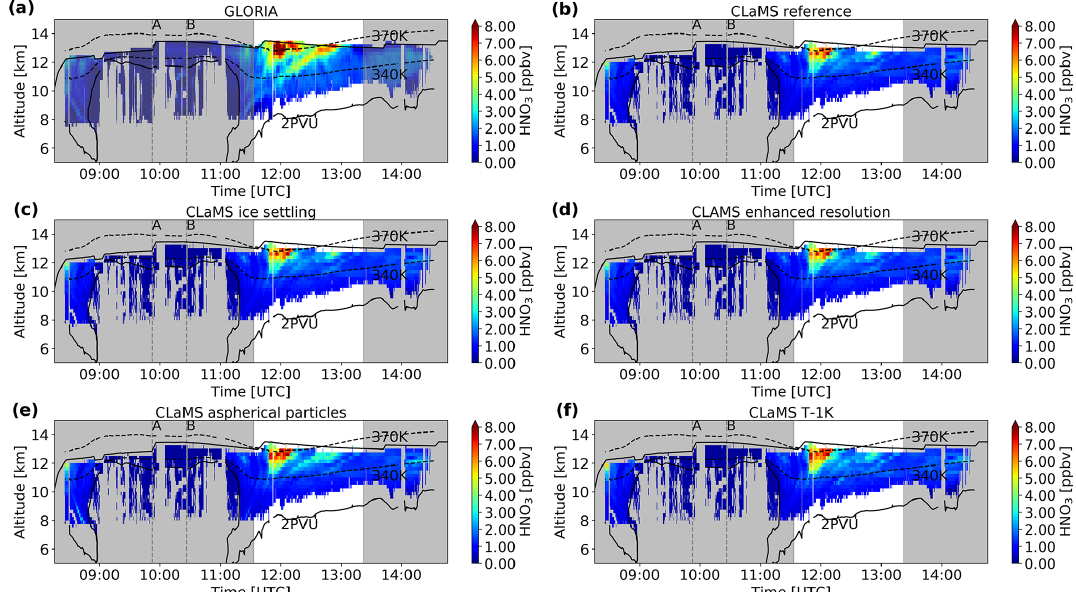
Figure B1. Cross sections of HNO 3 volume mixing ratio distribution for flight 6 on 12 January 2016 derived by GLORIA (a) and modelled by the CLaMS reference simulation (b) , and sensitivity simulations considering (c) ice formation on NAT particles, (d) temperature fluctuations, (e) growth rates of aspherical particles and (f) 1K global temperature offset. Flight altitude (bold black line), characteristic waypoints (A, B, C), 340 and 370K potential temperature levels (MERRA-2, dashed black lines), and 2PVU level (MERRA-2, black line).